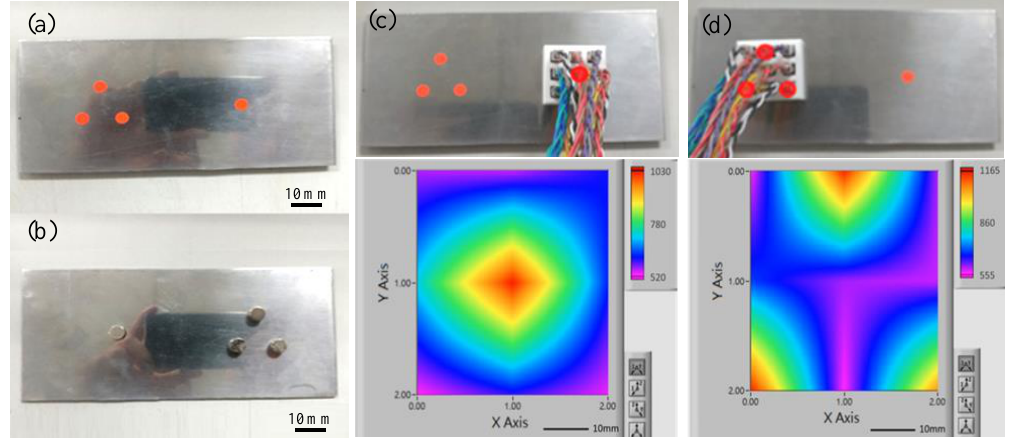
Figure 12. Photographs of: ( a , b ) front and rear sides of the iron plate with attached magnets; ( c , d ) single magnet and three-magnet detection arrangements and corresponded 2D magnetic field distributions (unit: Gauss).